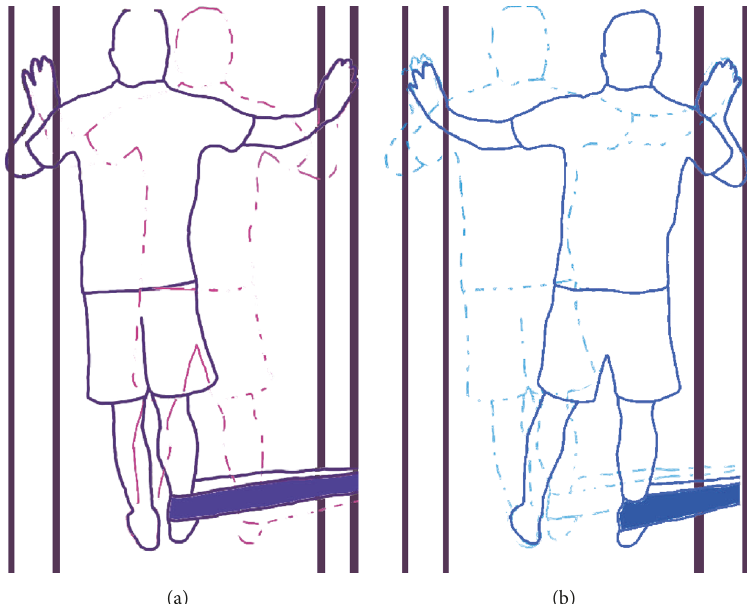
Figure 2: Isometric hip adduction. The subject tries to abstain from concentric or eccentric adductors contraction by moving his body in harmony with hip adduction (a) and coming back to the reference position